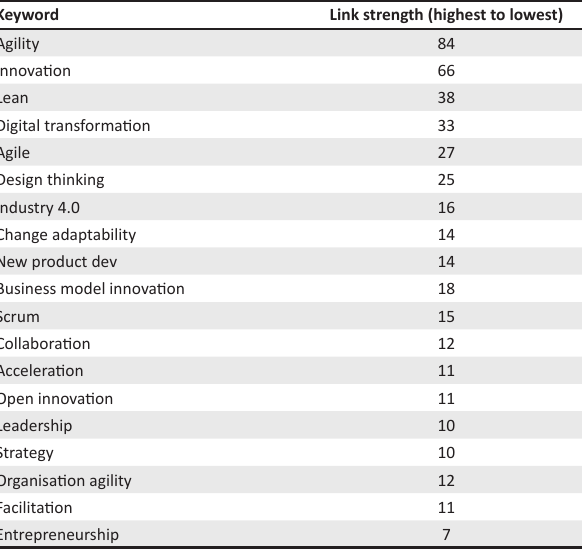
TABLE 3: Cluster analysis findings. TABLE 2: Top 20 keywords with high link strength.